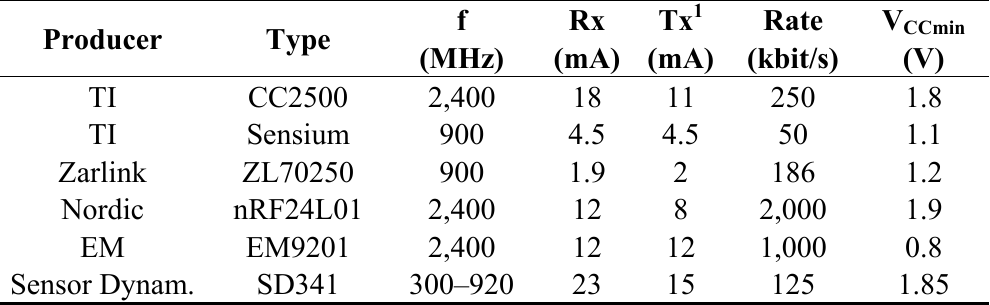
Table 3. The list of different microcontrollers and radio solutions considered for test